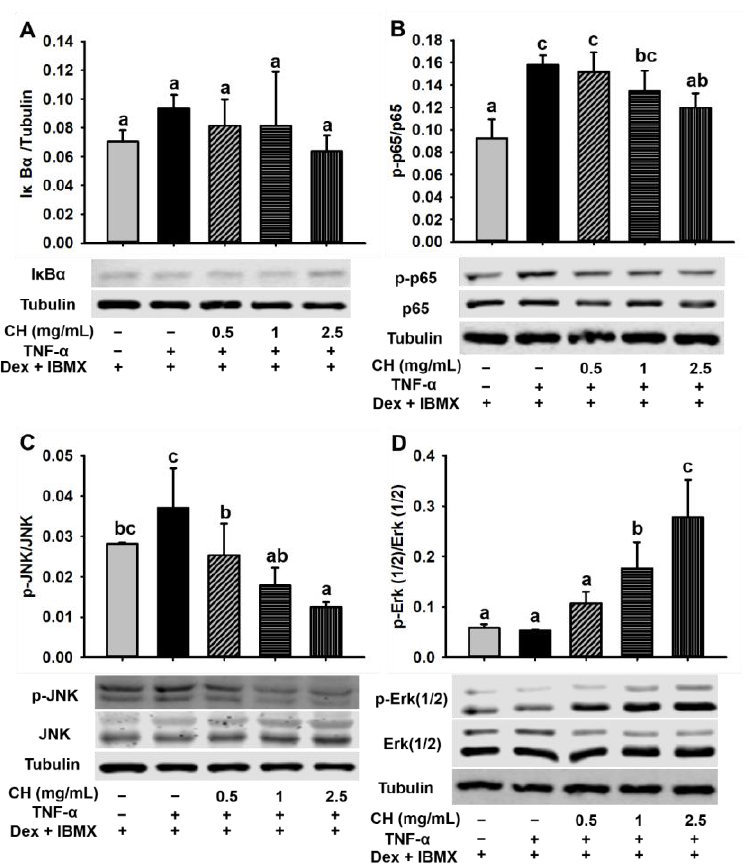
Figure 8. CH improved the adipocyte inflammation induced by TNF-α via the mediation of NF-κB p65 and MAPK signal pathway. 3T3-L1 cells were seeded in 6-well plates, and preincubated in differentiation medium containing 0.5, 1 and 2.5 mg/mL CH for 1 h, respectively. Then 10 ng/mL TNF-α was added and incubated for 24 h. Then, new differentiation medium containing the corresponding CH was replaced and cultured for another 48 h and 72 h. Western blot was used to detect the expression levels of IκBα ( A ), p-p65 ( B ), p-JNK ( C ), and p-Erk 1/2 ( D ). Different superscript letters meant a statistically significant difference at p < 0.05.